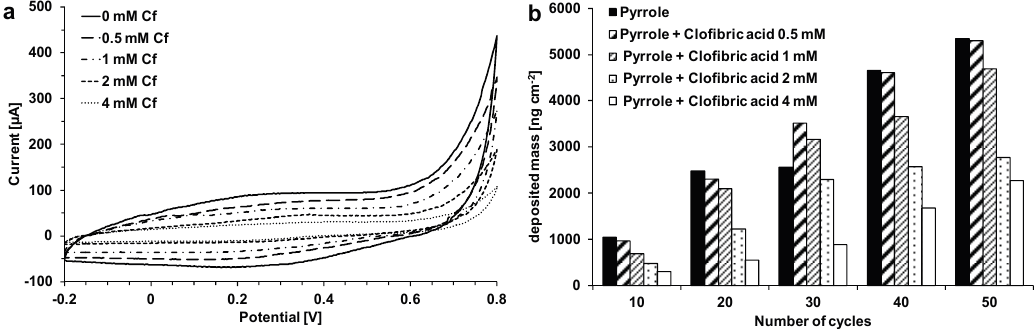
Figure 2. ( a) Cyclovoltammograms during polymerization of pyrrole (10 mM); imprinting with clofibric acid (Cf) (0–4 mM) in KNO 3 solution; ( b ) Influence of clofibric acid concentration on mass deposited after